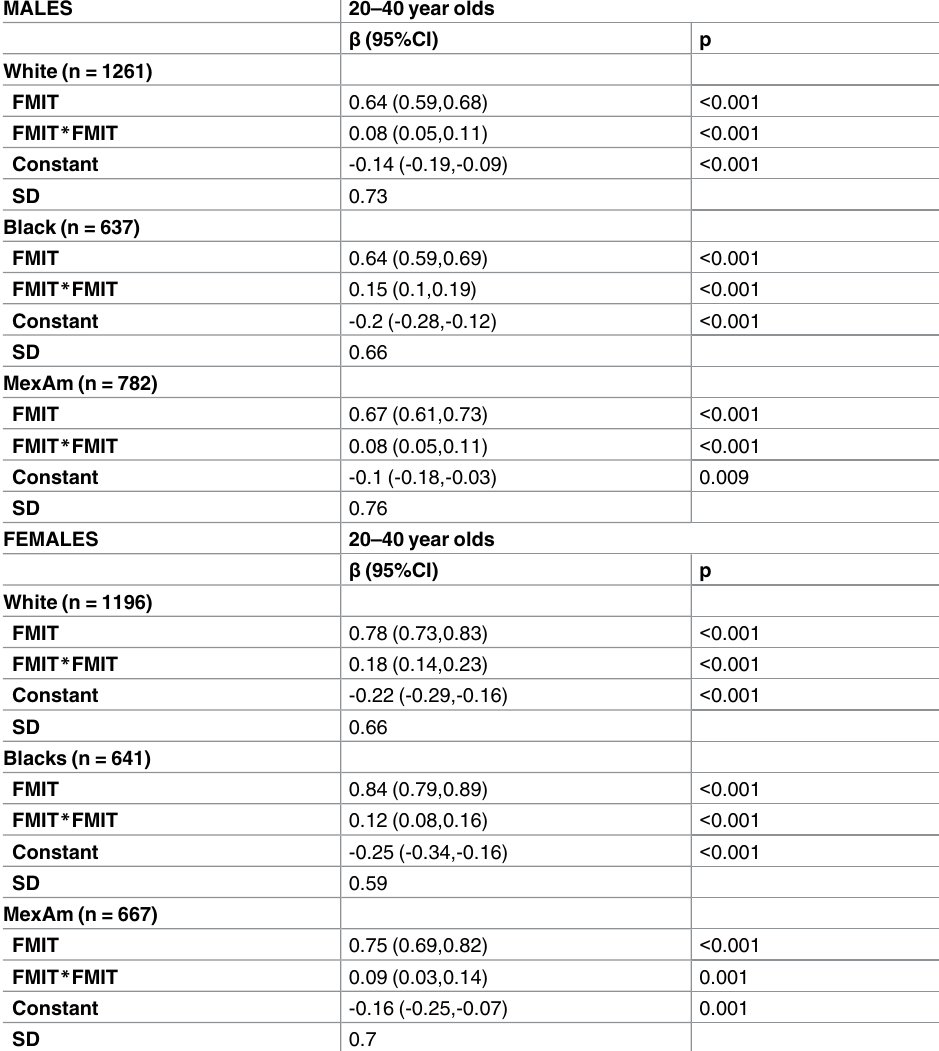
Table 2. Regression of FMI on ALMI Z-Scores within 20–40 year-olds.